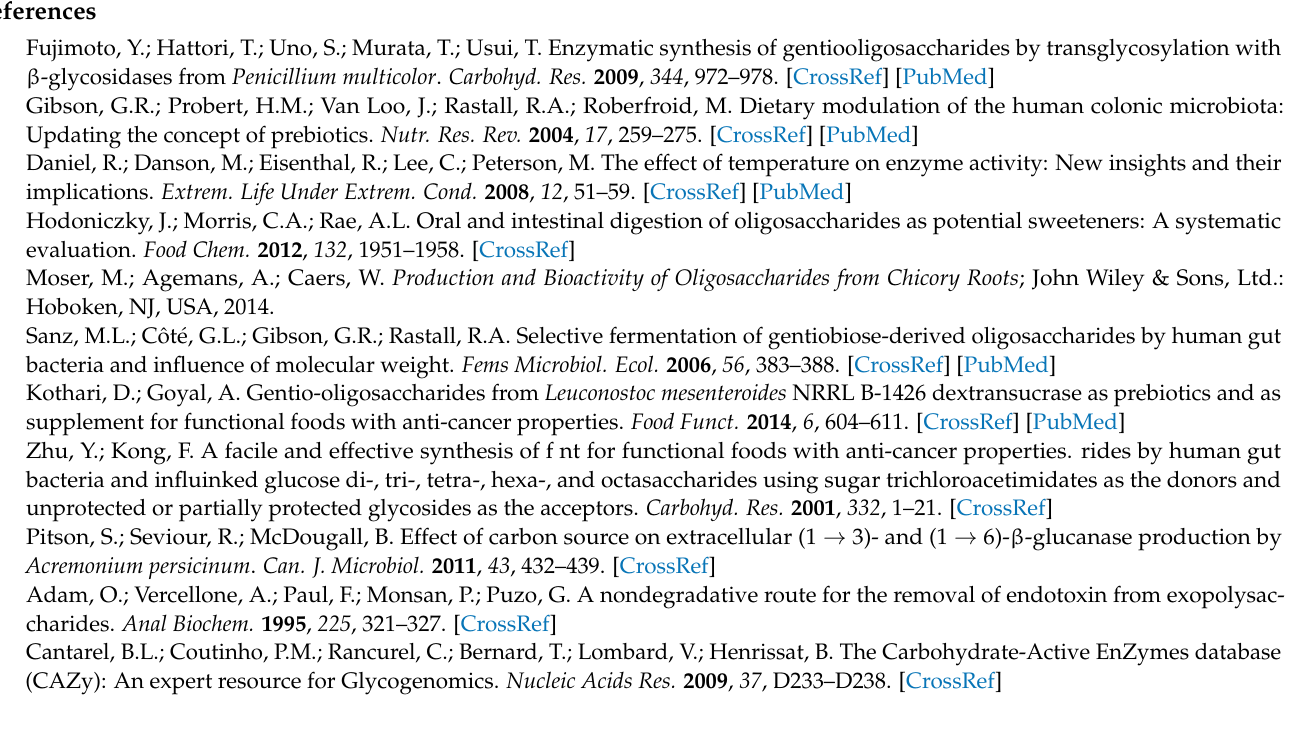
TsBgl1, Figure S1: Fitting curves of enzyme kinetics of TsBgl on different